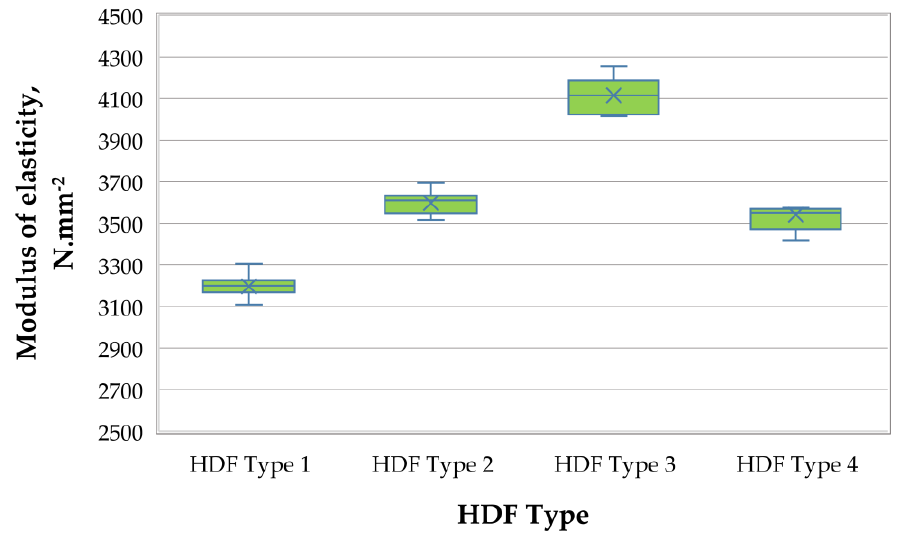
Figure 4. Modulus of elasticity (MOE) of HDF panels produced. The MOE of fabricated HDF panels reached high values, ranging from 3197